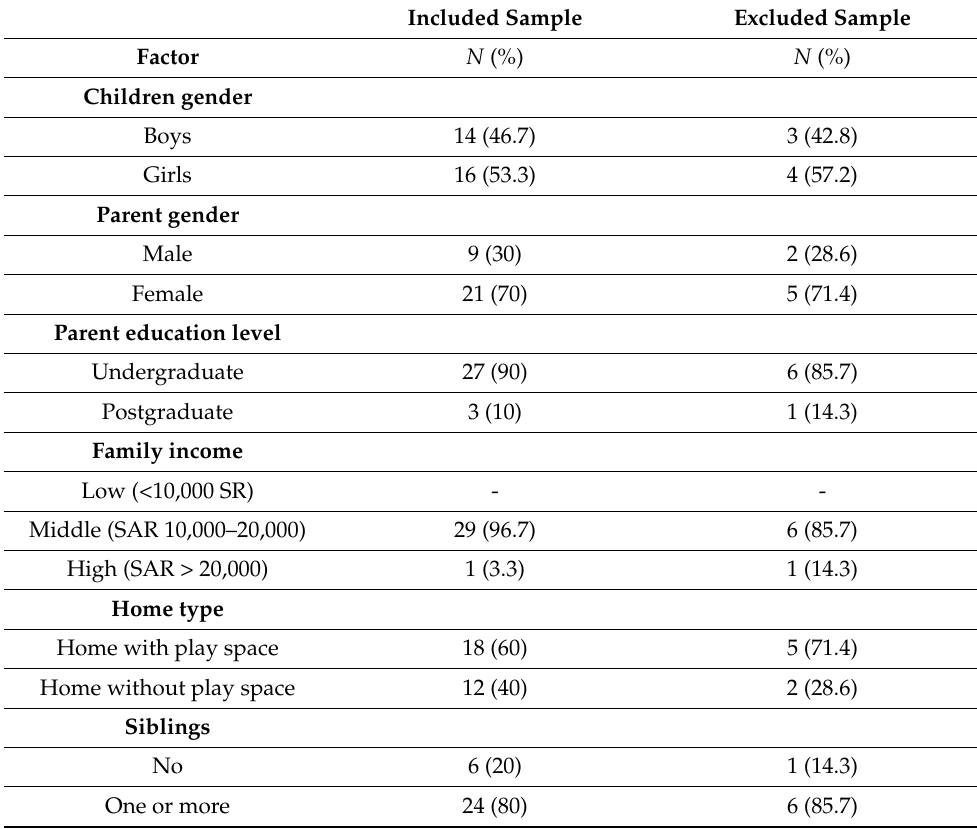
Table 1. Description of participants and family